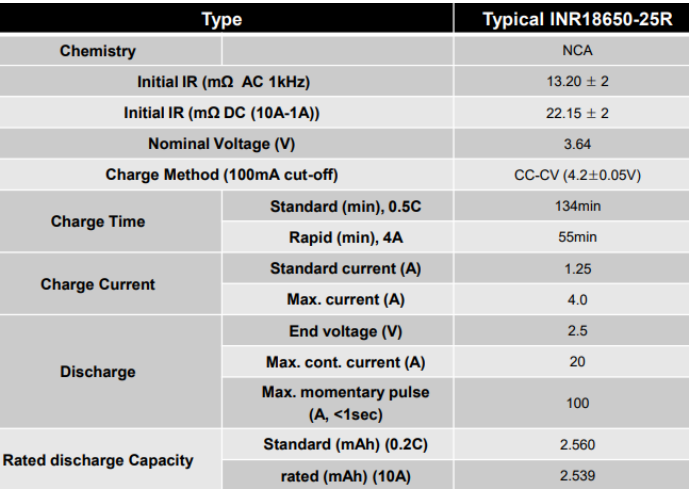
Figure 6. Parameters of the Samsung INR18650-25R battery cell [43]. Courtesy of